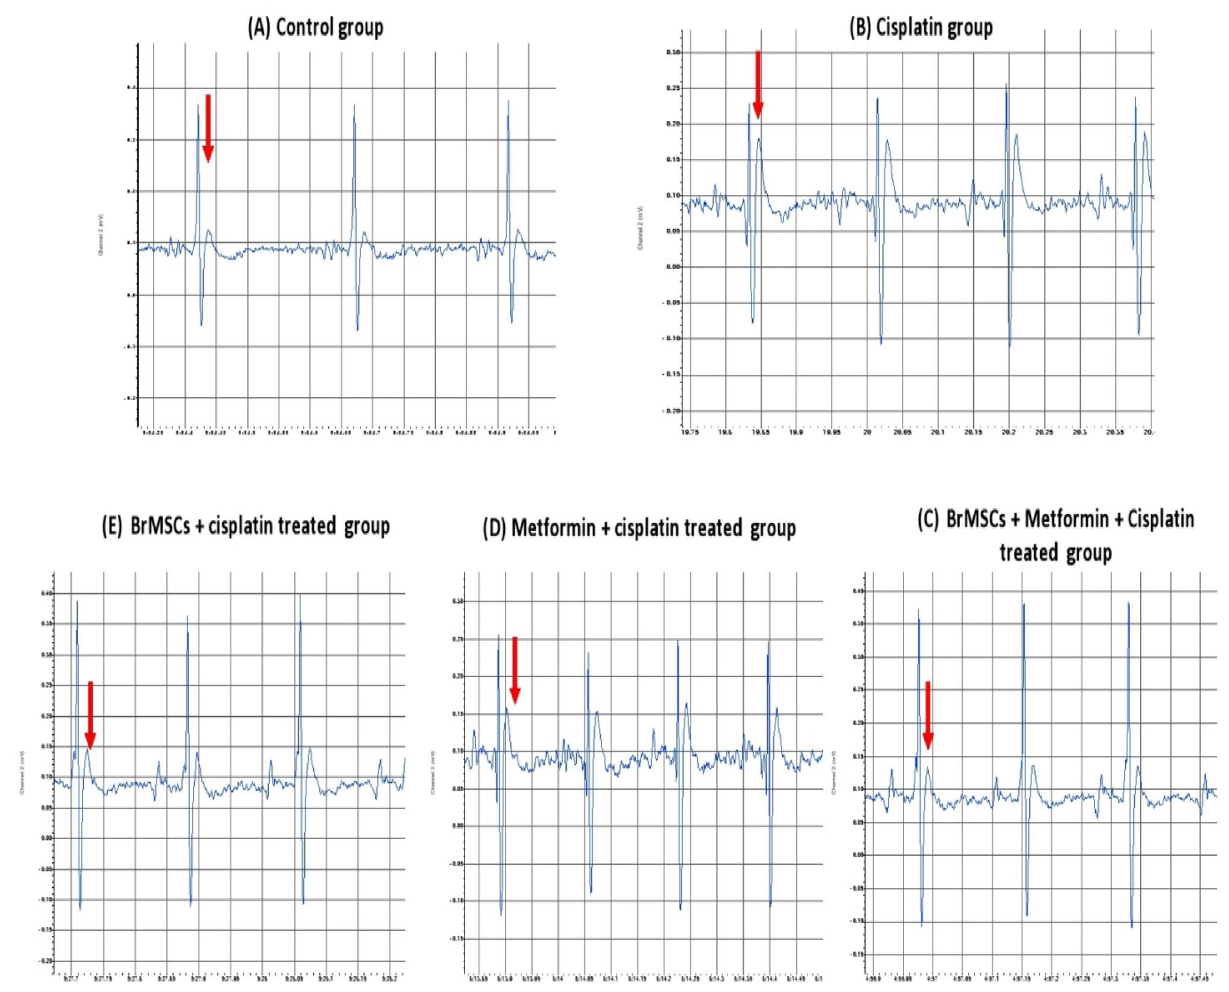
Figure 2. Effect of Br-MSCs, metformin, and their combination on ECG